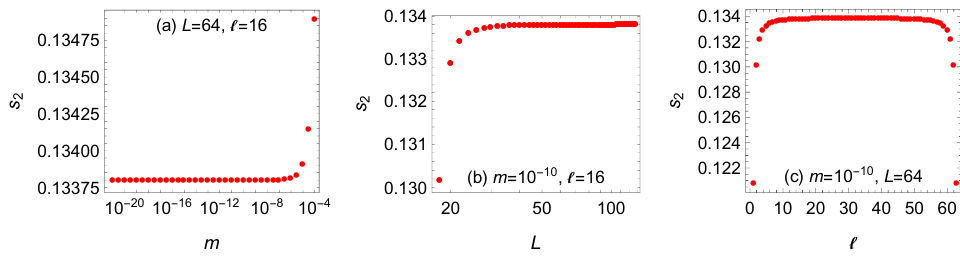
Figure 2 . The constant term of the single-interval ground state second Rényi entropy (4.3) is independent of m , L , ‘ in the massless and continuum limit of the harmonic chain. We read the approximate value s 2 ≈ 0 . 134 .